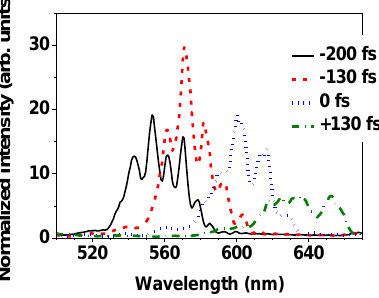
Figure 7. Spectra of the amplified signal pulse at time delays of −200 fs (solid line), −130 fs (broken line), 0 fs (dotted line), and 130 fs (dashed-dotted line). All the spectra are normalized to the peak intensity of the output signal spectrum obtained without use of the pump